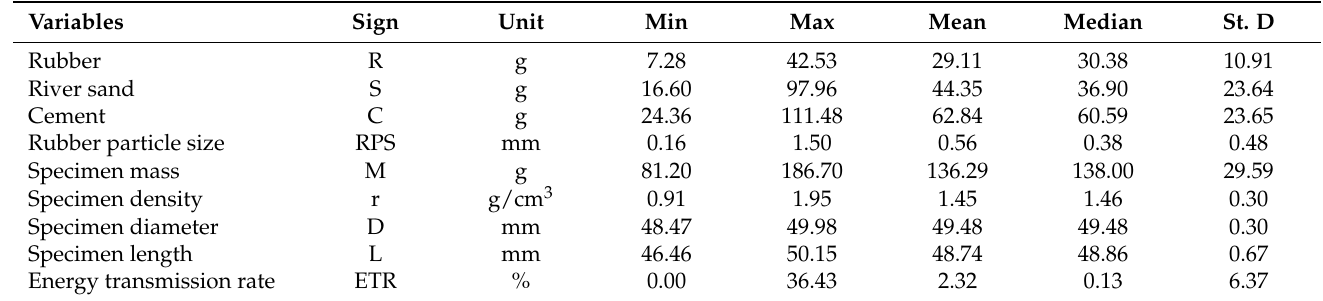
Table 4. The detailed description of all considered parameters for the ETR